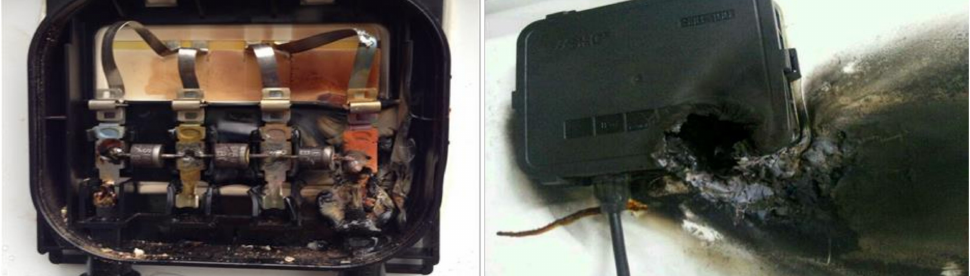
Figure 12. Junction box